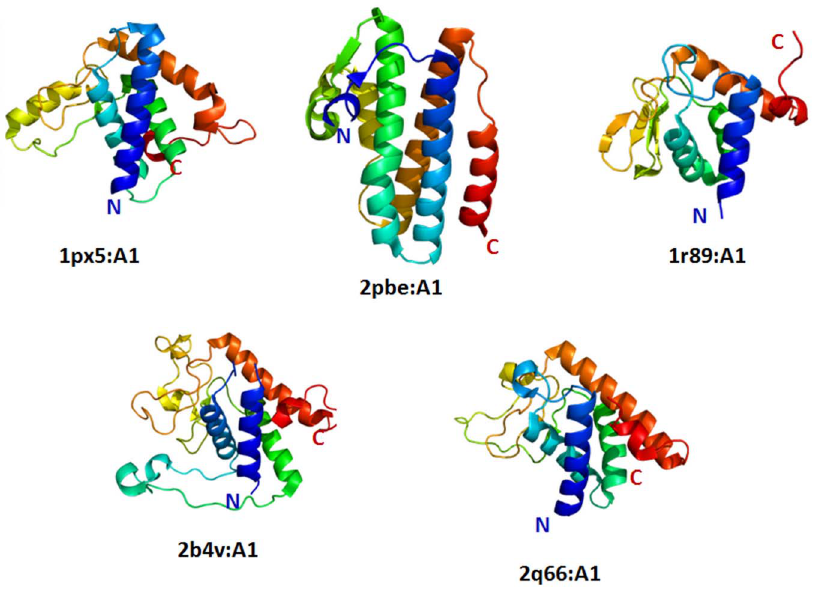
Figure 7. Structural view of all the domains PAP/OAS1 substrate-binding domain superfamily. Among the five domains, 2pbe:A1 is structurally and functionally different member. The architecture of the domain is different from all the other domains.